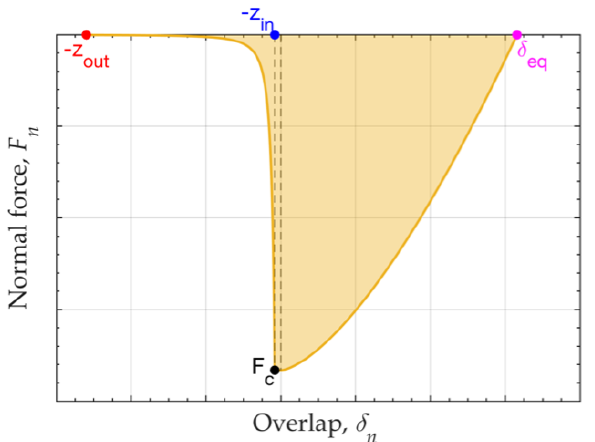
Figure A3. Normal force vs. overlap according to the VDW cohesion